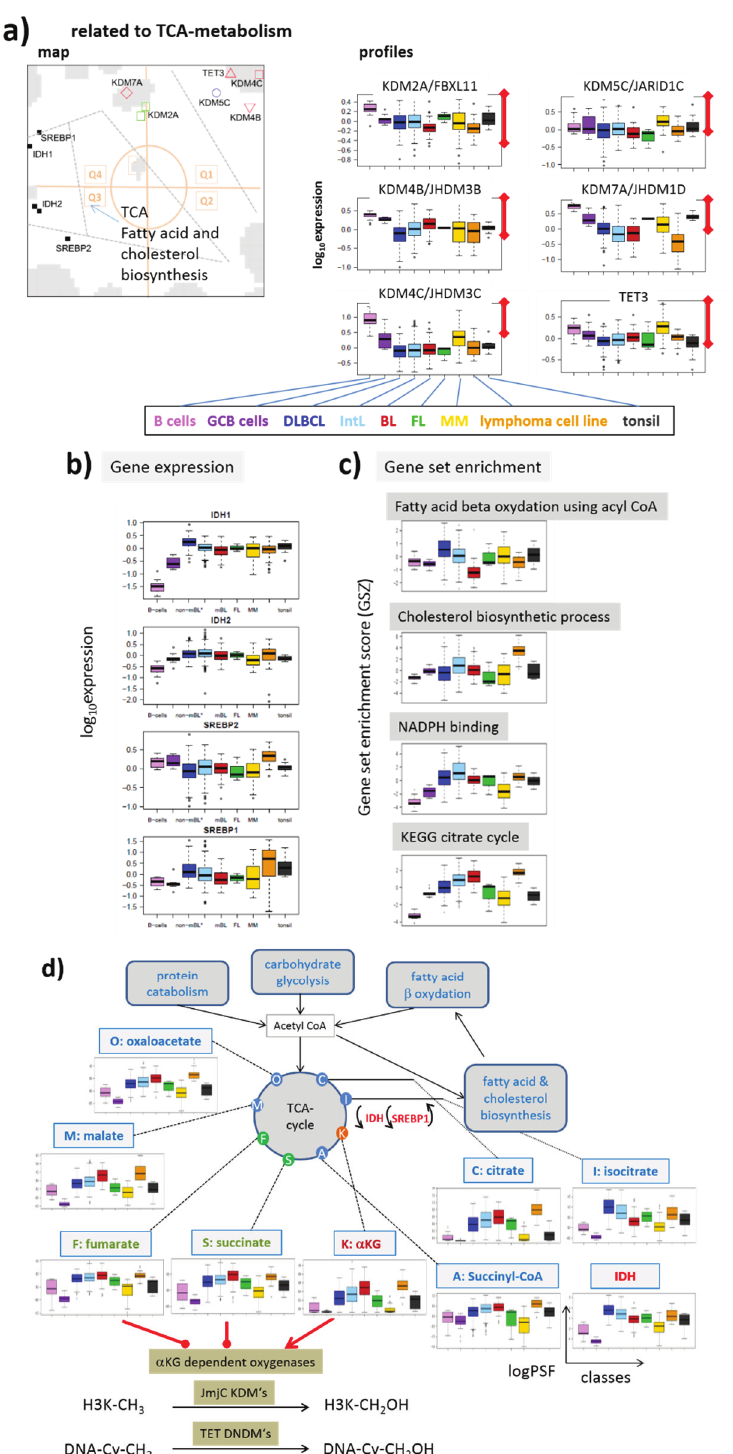
Figure 9. TCA-cycle related epigenetic compounds: ( a ) overview map and profiles of histone JmjC- and DNA TET-demethylases; ( b ) gene expression profiles of TCA-related enzymes and ( c ) gene set enrichment profiles of GO-gene sets related to TCA; ( d ) PSF-profiles of metabolic products along the TCA-cycle. Fumarate and succinate can act as antagonists of (cid:2)KG to inhibit (cid:2)KG-dependent dioxygenases. Note that the PSF profiles of all metabolites are very similar and virtually are anti-correlated with the expression of the demethylases shown in part